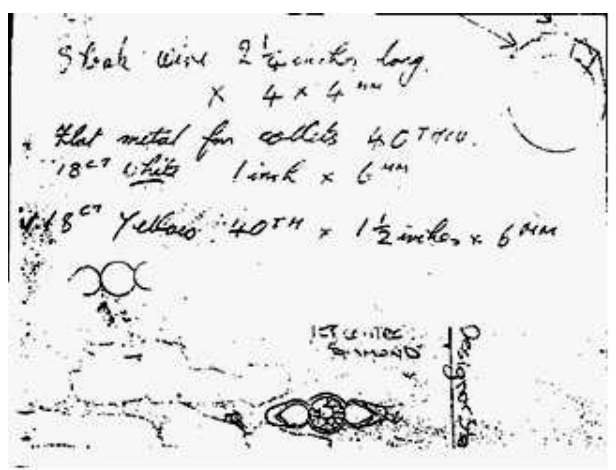
Figure 2. A jeweller’s sketch